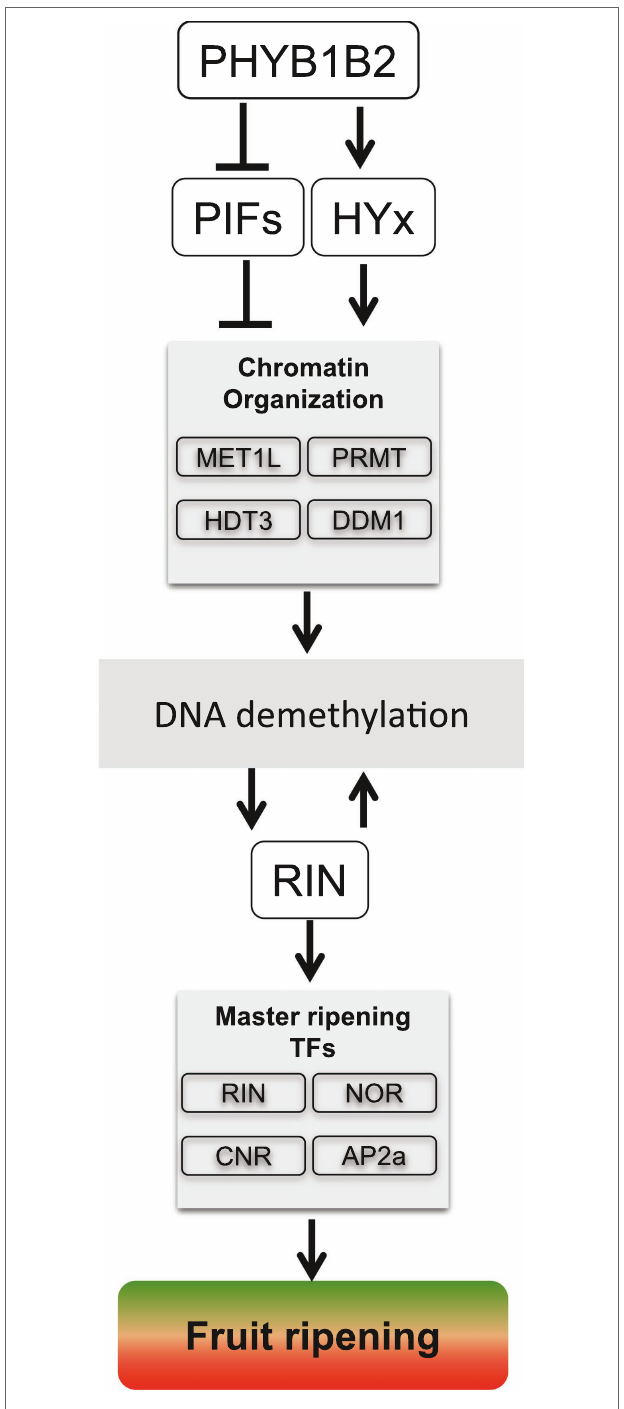
FIGURE 7 | Conceptual model linking PHYB1B2 receptors, epigenetic mechanisms of gene expression regulation and fruit ripening. Active PHYB1B2, through the inactivation of PIFs and stabilization of HYx, regulates the expression of chromatin organization associated genes such as METL1, PRMT, HDT3, and DDM1, resulting in DNA demethylation and the induction of RIN ripening master TF expression. RIN targets include chromatin organization genes resulting in a positive feedback loop. Moreover, RIN enhances its own transcription, as well as other TFs (such as NOR , CNR , and AP2a ) that finally induce a myriad of effectors triggering